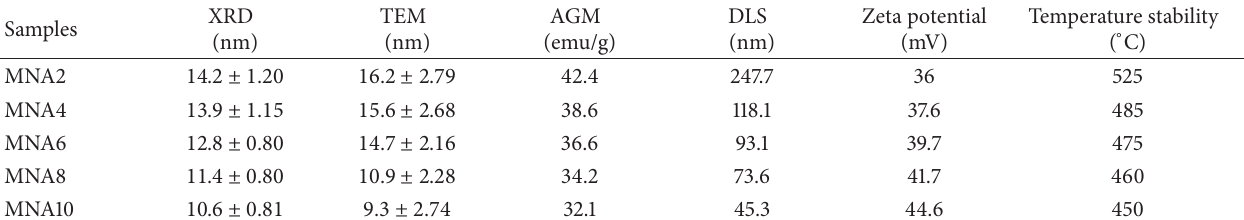
) of maghemite nanoparticles. S